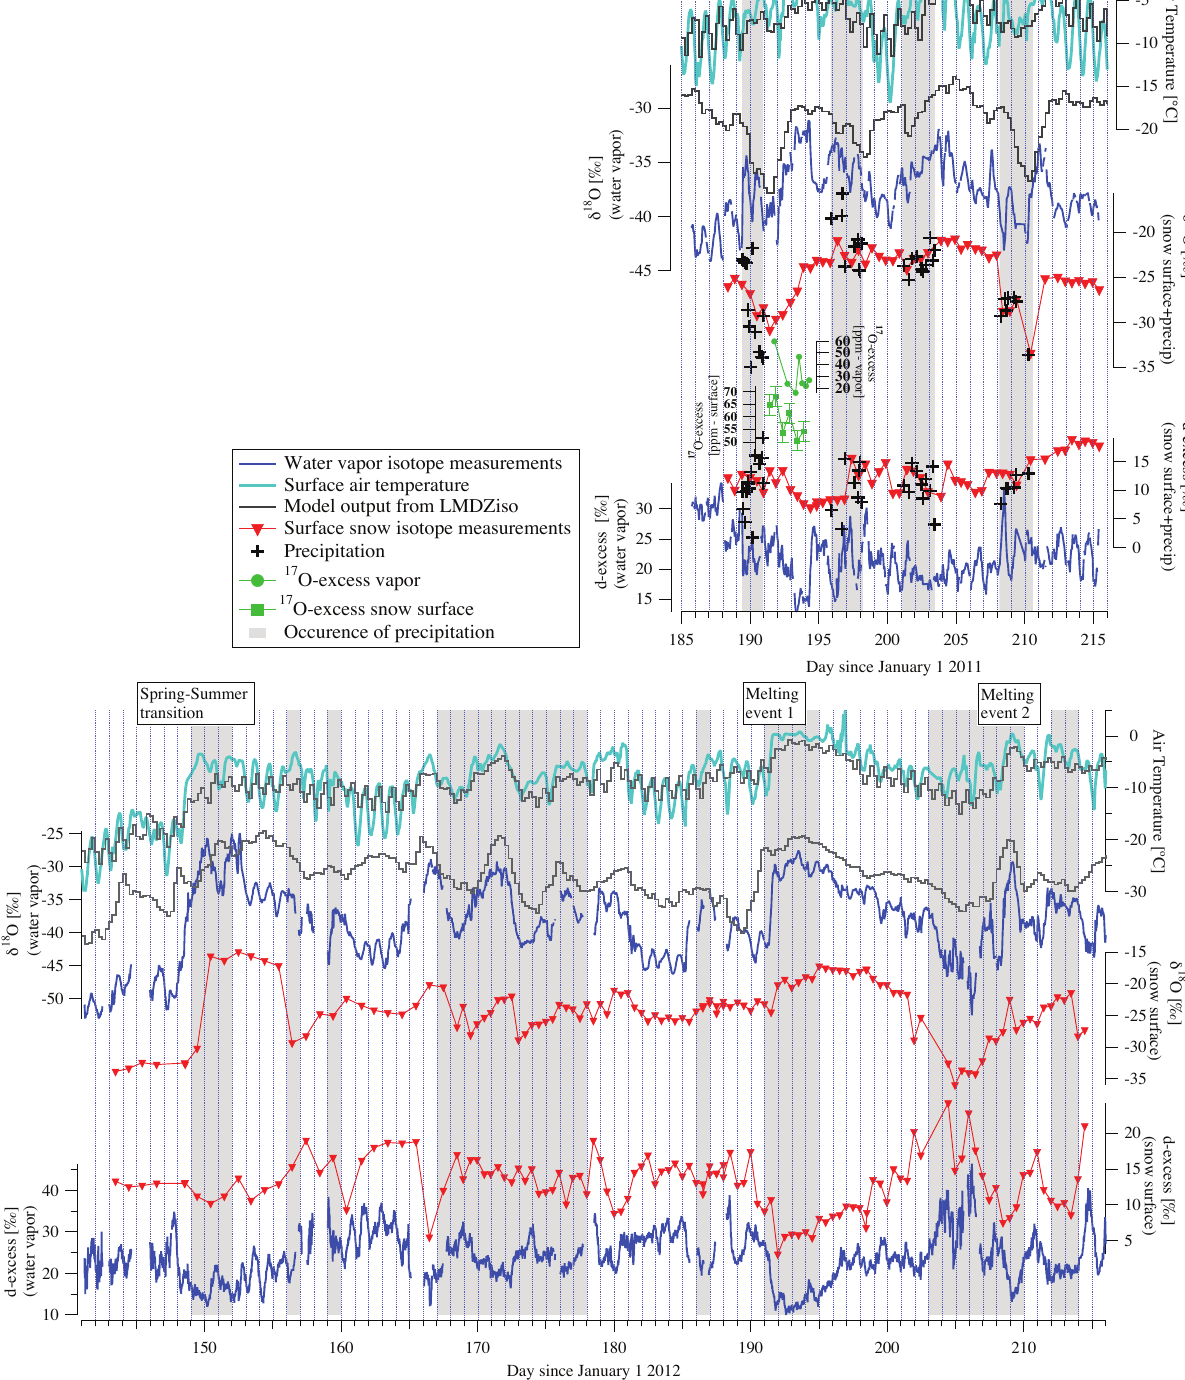
Fig. 1. The observed water vapor isotope signal during the 2011 (top panel) and 2012 (bottom panel) field season at NEEM (shown in blue) together with the concomitant variability in the surface snow isotopes (show in red). Air temperature from local GC-Net station shown in cyan. Model outputs from LMDZiso shown with solid dark-gray line. Occurrence of precipitation indicated by vertical gray columns. Precipitation samples collected in 2011 on sub-event shown with black crosses in top